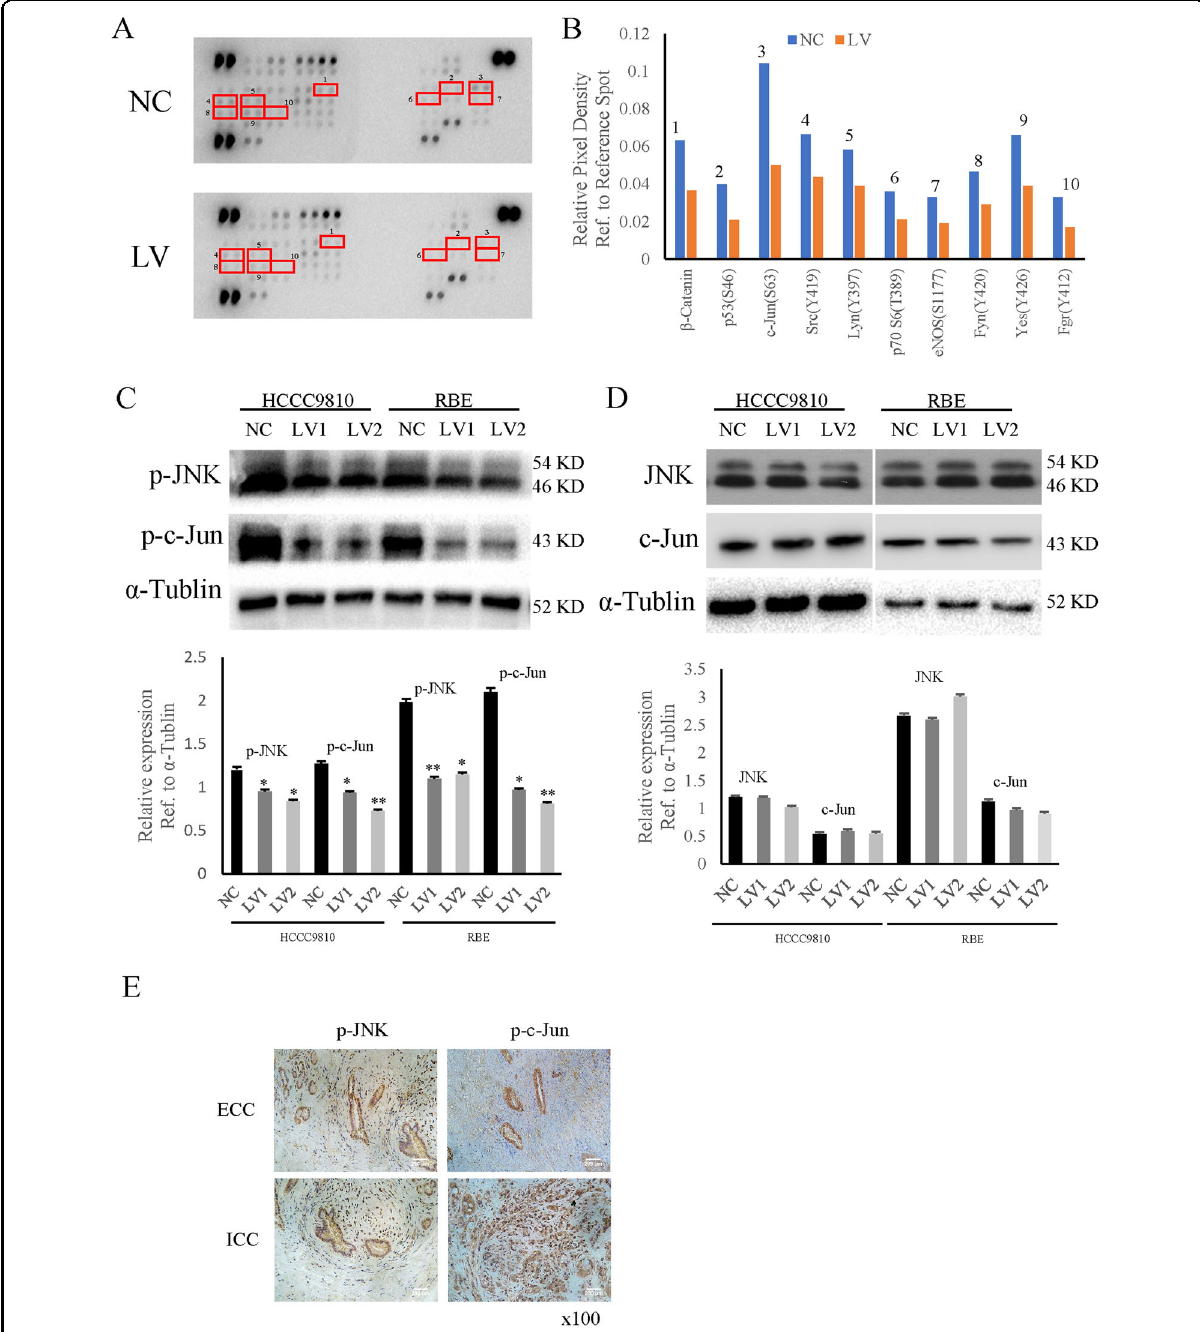
Fig. 4 BUB1B regulated the expression of the JNK-c-Jun signaling. A , B Protein-chip analyses were performed. The knockdown of BUB1B suppressed the expressions of a series of proteins associated with tumor growth and invasiveness. C , D The expressions of JNK and c-Jun were detected by western blot. The expressions of phosphorylated c-Jun and JNK were inhibited in BUB1B-knockdown group. E The expressions of JNK and c-Jun in CCA were con fi rmed by IHC staining (* p < 0.05; ** p <